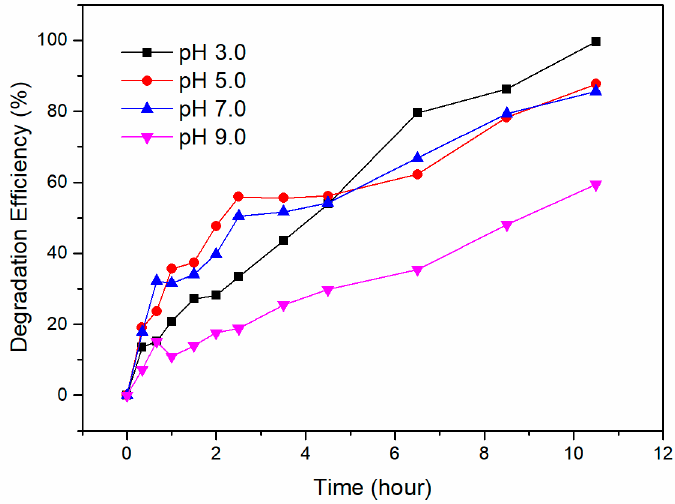
Figure 5. Cr (VI) removal efficiencies under different pH values by MFCs equipped with pyrrhotite- coated